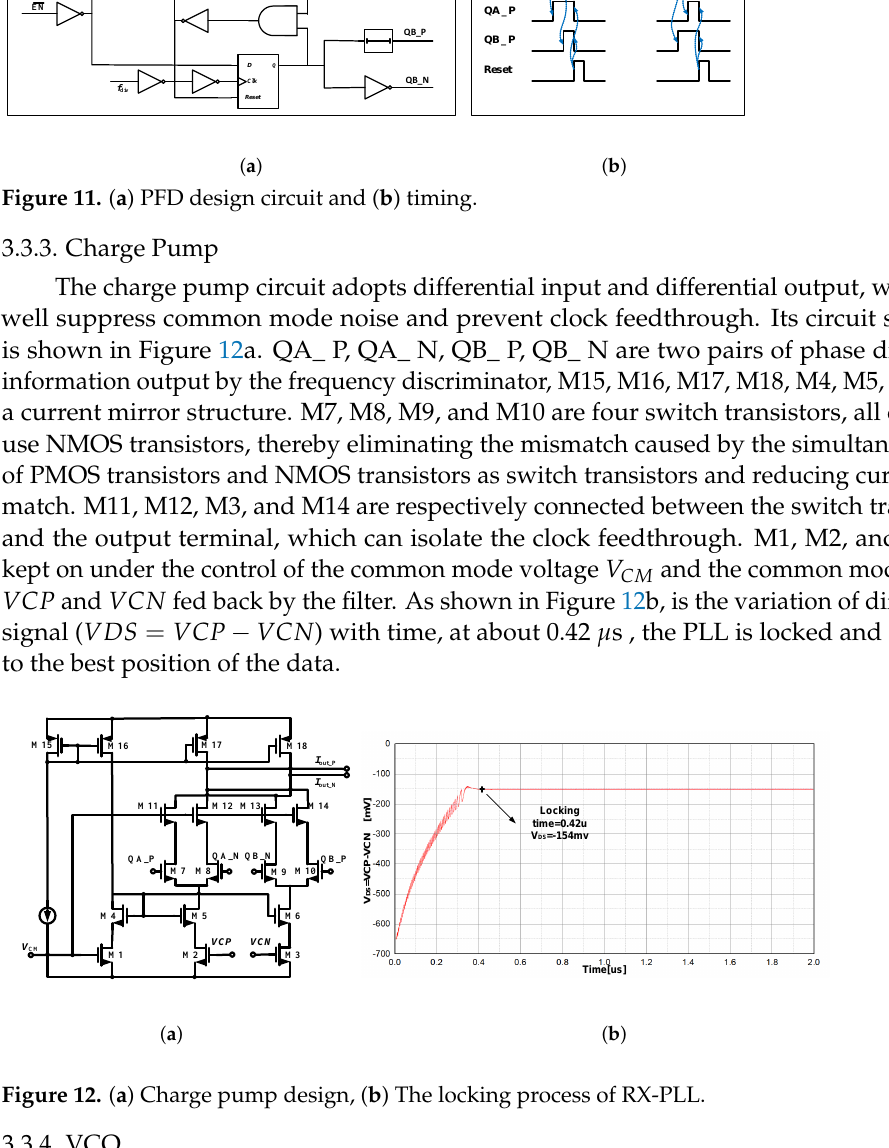
Figure 11b is the working sequence diagram of the frequency and phase detector.